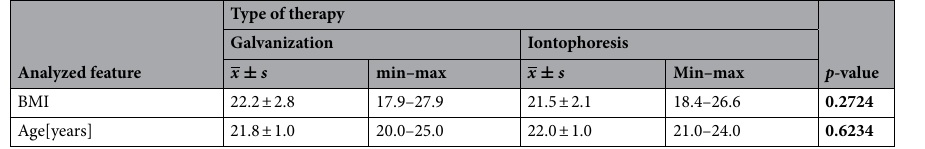
Table 1. Characteristics of the studied groups in terms of body mass index and age. p -test probability value calculated using the independent samples t-test.